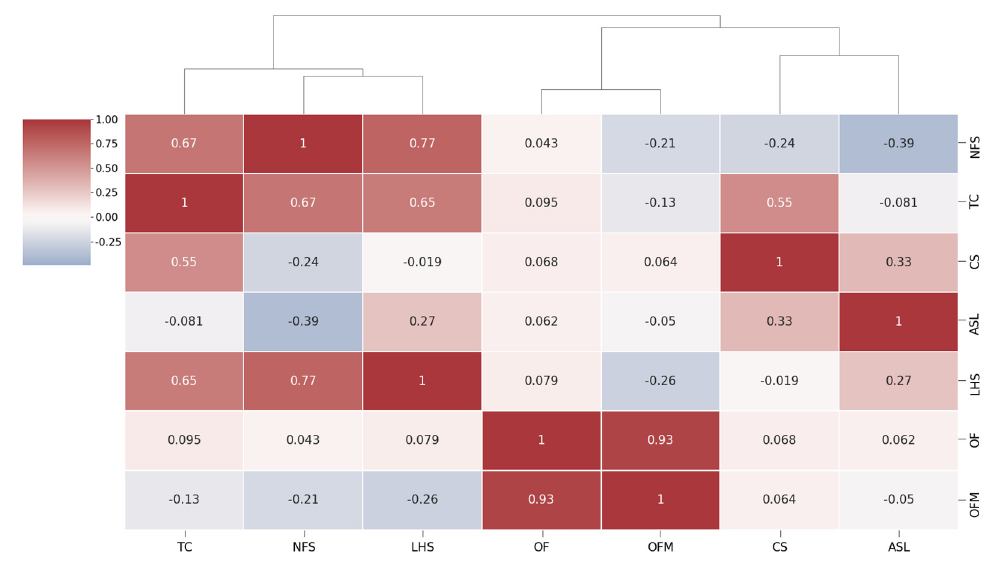
Figure 2. Thermal clustering diagram of horizontal well process design parameters.